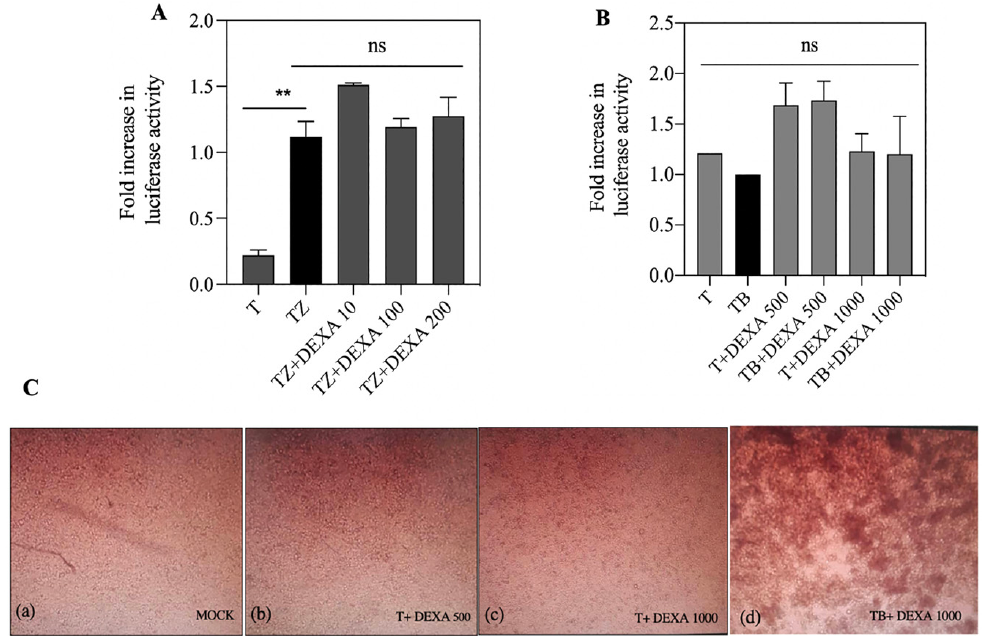
Figure 6. Transfected cells were treated for 18 h with indicated concentrations of dexamethasone in combination with zVAD.fmk (25 µM), BV6 (3 µM) and TNF α . SH-SY5Ycells were treated for 18 h with ( A ) TZ and ( B ) (TB) in the absence or presence of DEXA (concentrations indicated). ( C ) Morphology was visualized and photographed under a light microscope that cells become round and detached in medium after 18 h. Each graph shows the mean ± SD; n = 3 independent repeats. ns, not significant; ** p ≤ 0.01. 4. Discussion Split luciferase complementary assay has been used to keep track of the RIPoptosome complex formation between RIPK1 and FADD (Figure 1). Upon activation of TNFR1 in presence of a pan-caspase inhibitor (TZ) (Figure 2A), the increase in split luciferase activity indicates proper juxtaposition of complex subunits in presence of zVAD.fmk despite TNF α alone which might indicate resistance to TNF α in the absence of caspase 8. As well, lack of expression of caspase 8 has been documented as a resistance approach to TRAIL and chemotherapy in neuroblastoma cells [42]. However, to confirm right reporter interactions, mutation of critical involving residues has been implemented. There are many post-translational modifications (PTM) sites, such as ubiquitination, that are important in the TNF α signaling pathway [12]. RIPK1, as a mediator with different PTM sites, is more prone to ubiquitination in different sites especially in DD conduct TNFR1 pathway to cell death or survival [43]. K612 of RIPK1 has a pivotal role in its interaction with FADD [39]. The interaction of FADD/RIPK1 contributes to complex IIb which contains activated RIPK1, FADD and caspase 8 to mediate the activation of caspase 8 and apoptosis [44]. Mutation of K612 to R brought about with the loss of luciferase complementary activity presumably due to loss of proper interactions (Figure 3).